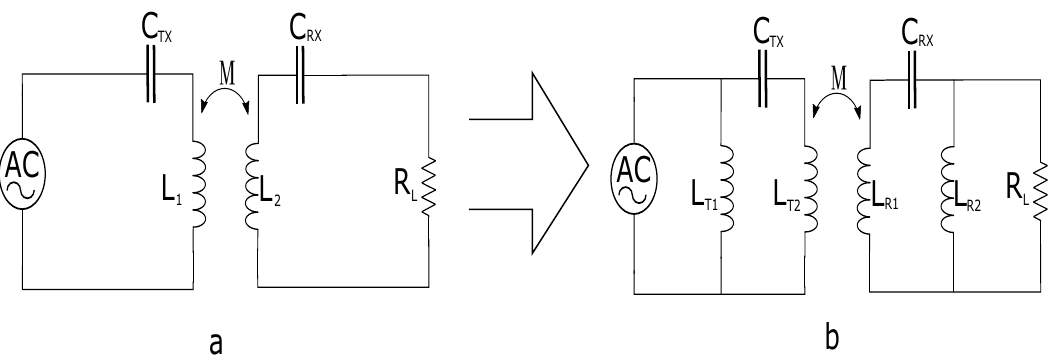
Figure 2. ( a ) A comparison between the conventional WPT system with a single set of coils ; and ( b ) the proposed technique with an additional